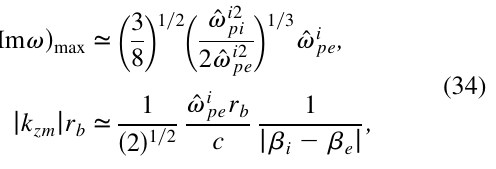
FIG. 10. Plots of (a) (cid:1) Im ! (cid:2) = ^ ! i (cid:7) 0 : 2 , (cid:15) (cid:7) 0 : 1 , and ^ ! i = 3 , (cid:15) r w b e